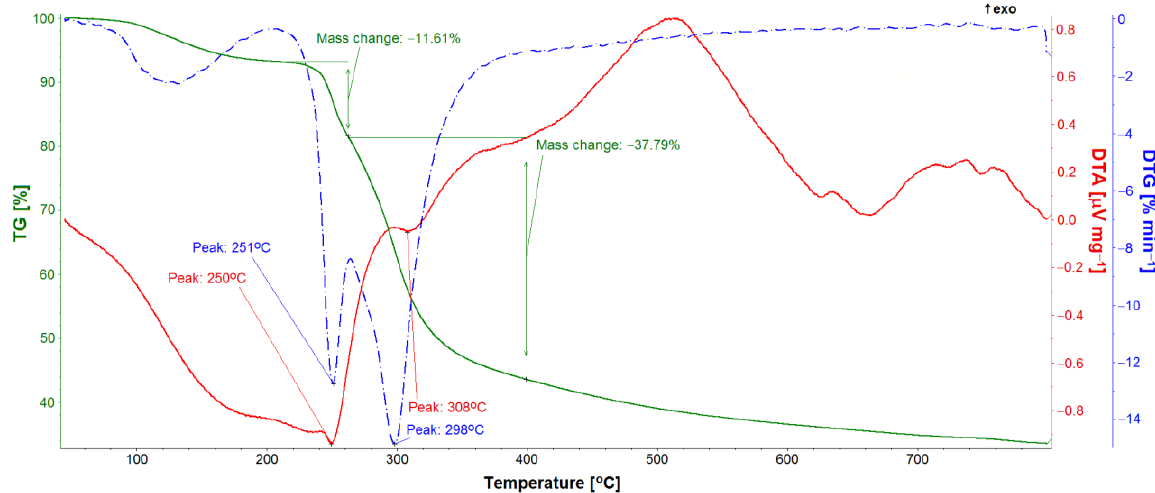
Figure 11. TG, DTA, and DTG curves of gentamicin sulfate sample.